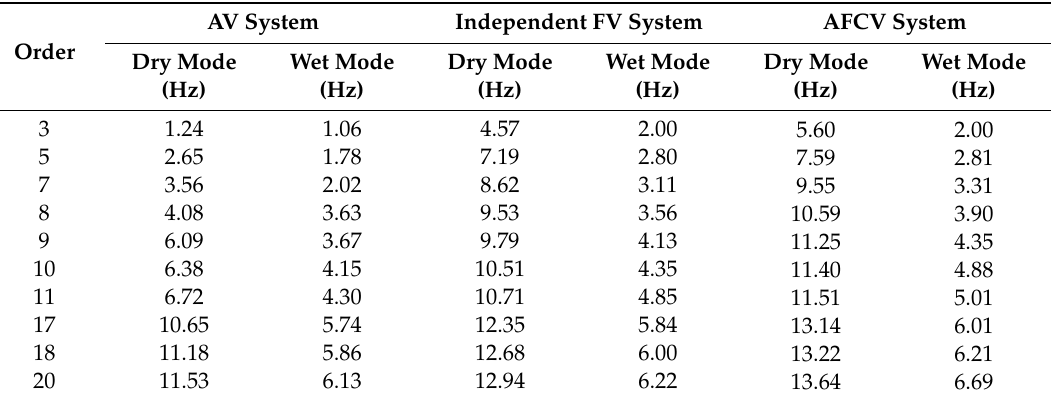
Table 3. Natural frequencies of the guide